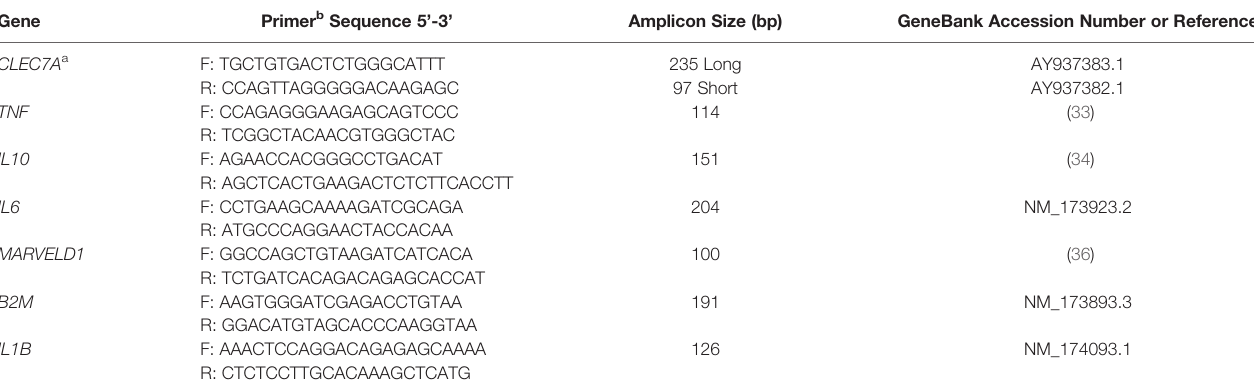
TABLE 1 | List of primers used for quantitative real-time